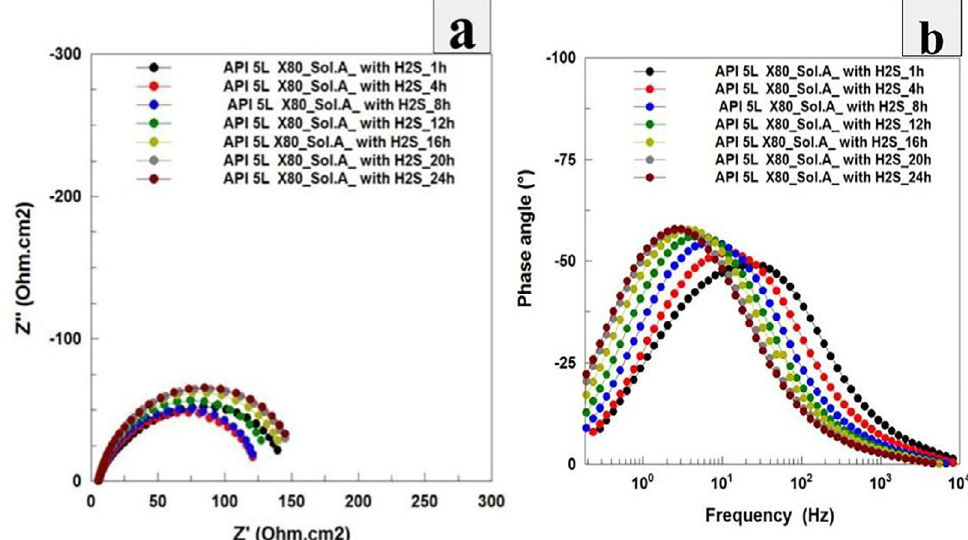
Figure 10. Nyquist (a) and phase angle (b) diagrams for the API 5L API 5L X80 steel during 24h immersion in deaerated solution A, NACE TM0284 (2011), saturated with H